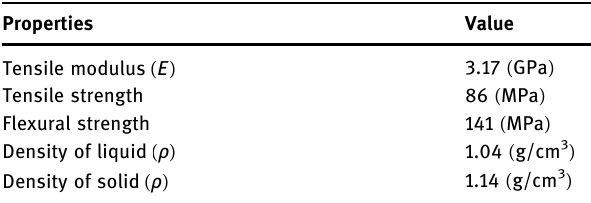
Table 1: Mechanical properties of Hetron 922 vinyl ester resin [ 20 ]